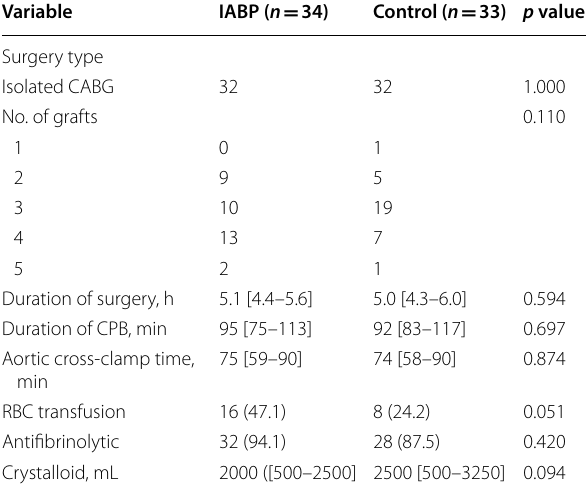
Table 1 Demographic and baseline characteristics Table 2 Intraoperative